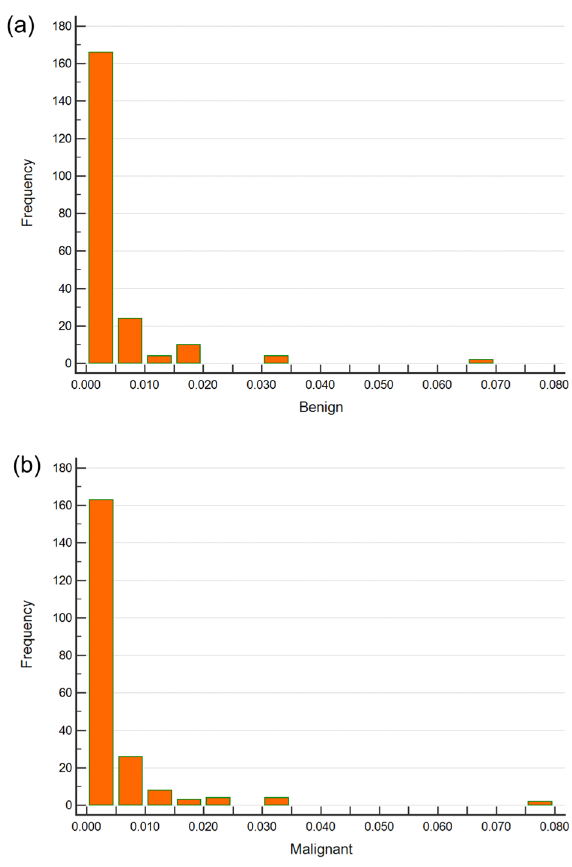
Figure 4. Histograms of PHOG Descriptors for Benign and Malignant Tumours in US Images. The histograms of PHOG descriptors that extracted local shape and the spatial layout from images and quantified them as vectors for ( a ) a probably benign US image (Fig. 2a, level = 2, bin = 30, total 630 features) and ( b ) a moderate suspicion for malignancy US image (Fig. 3a, level = 2, bin = 30, total 630